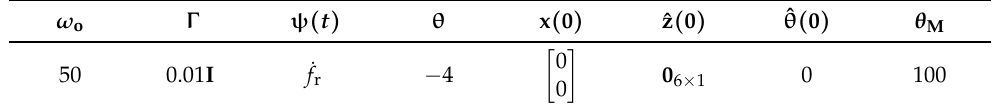
Table 4. Parameters of the simulation of PIESO used for frequency identification.